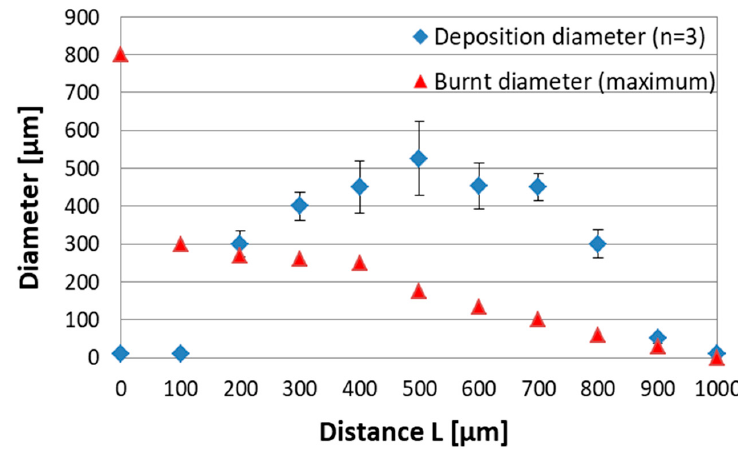
Figure 6. Measurement results of deposited particles and burnt diameter at each distance. The deposition diameter was maximized at the distance L = 500 µm, whereas that for the burnt diameter was at the distance L = 0.